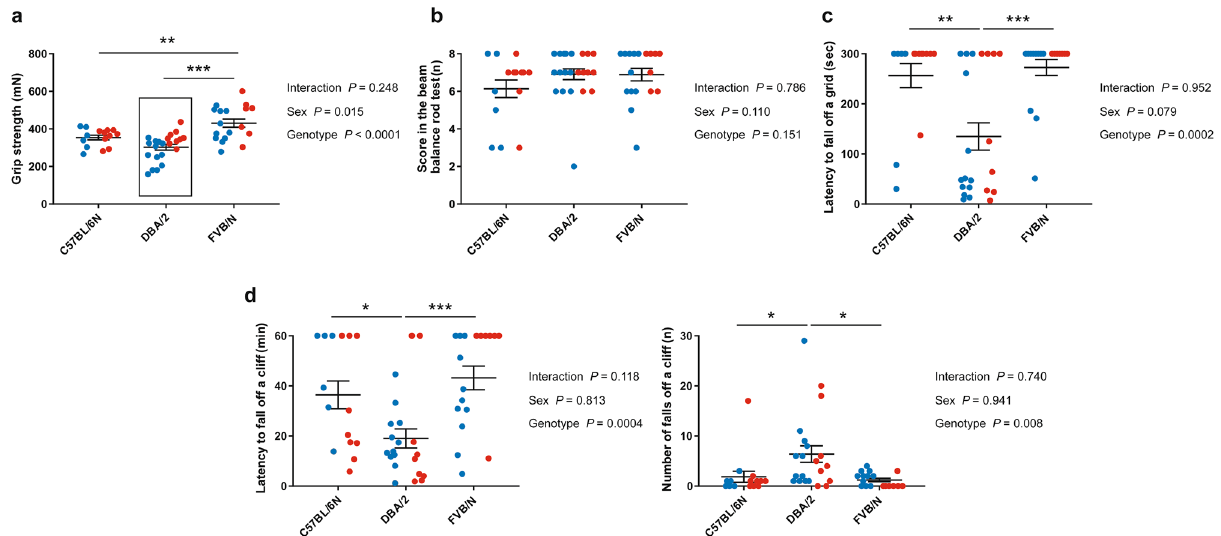
Figure 1. Coordination function in the P22–30 cohort of C57BL/6N, DBA/2, and FVB/N strains. ( a ) The grip strength test revealed increased grip strength for FVB/N mice compared to C57BL/6N and DBA/2 mice. ( b ) The beam balance rod test showed no difference between the three investigated strains. ( c ) DBA/2 mice displayed the lowest latency to fall off the grid in the inverted screen test. ( d ) In the cliff avoidance reaction test, DBA/2 mice exhibited the lowest latency to fall off the cliff (left) and the highest number of falls (right) compared to C57BL/6N and FVB/N mice. Two-way ANOVA followed by Tukey post hoc test, * p ≤ 0.05, ** p ≤ 0.01, *** p ≤ 0.001. A black rectangle indicates a significant difference between sexes within a strain (see Supplementary Table 2). Blue and red dots refer to males and females, respectively. Error bars indicate the standard error of the mean